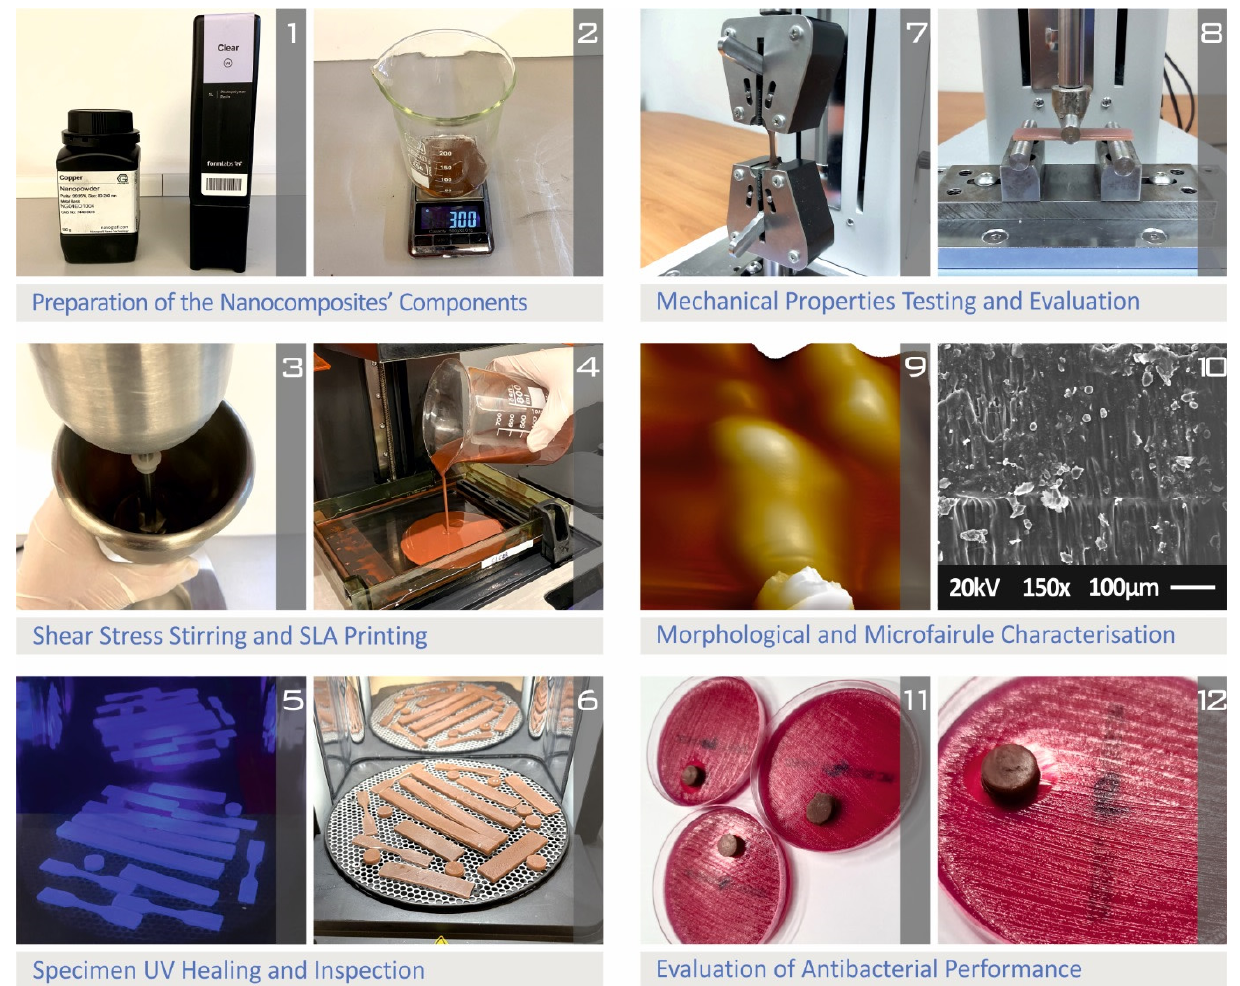
Figure 1. Workflow presentation of the followed processing using images captured during the study.